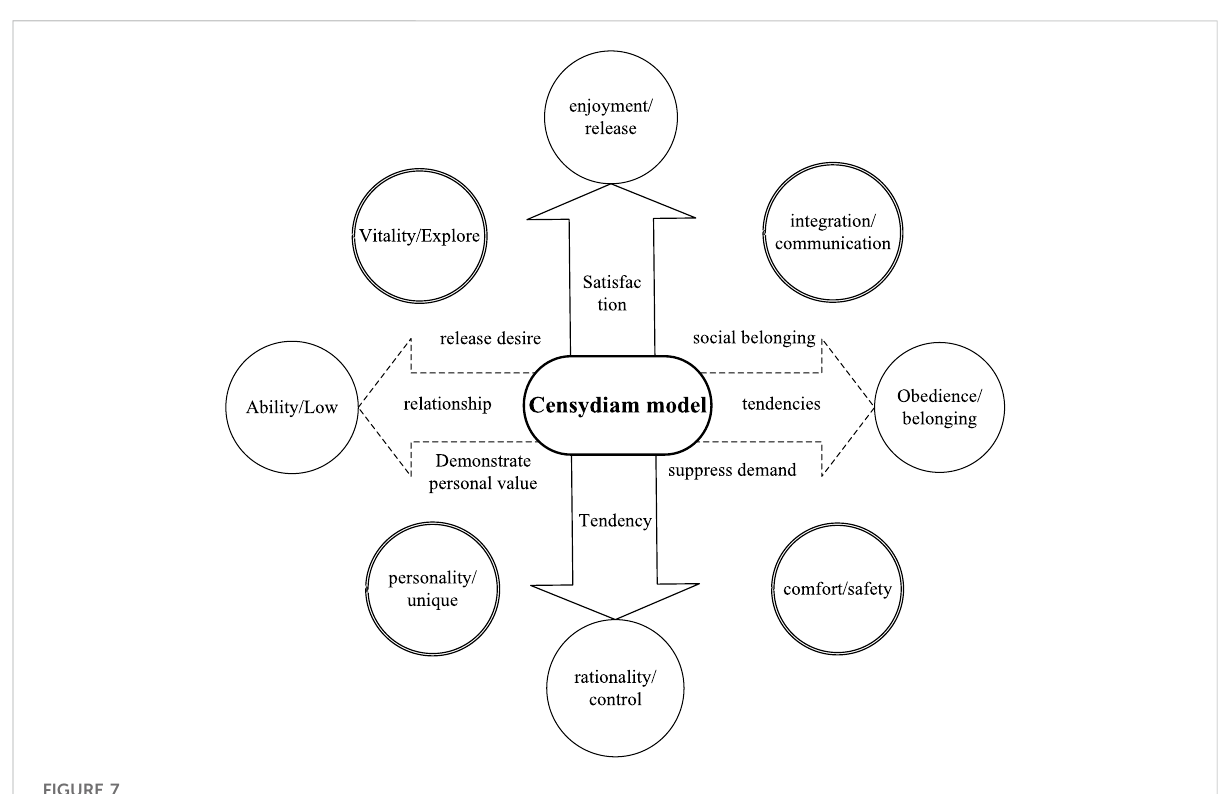
FIGURE 7 8-Quadrant censydiam consumption analysis motivation